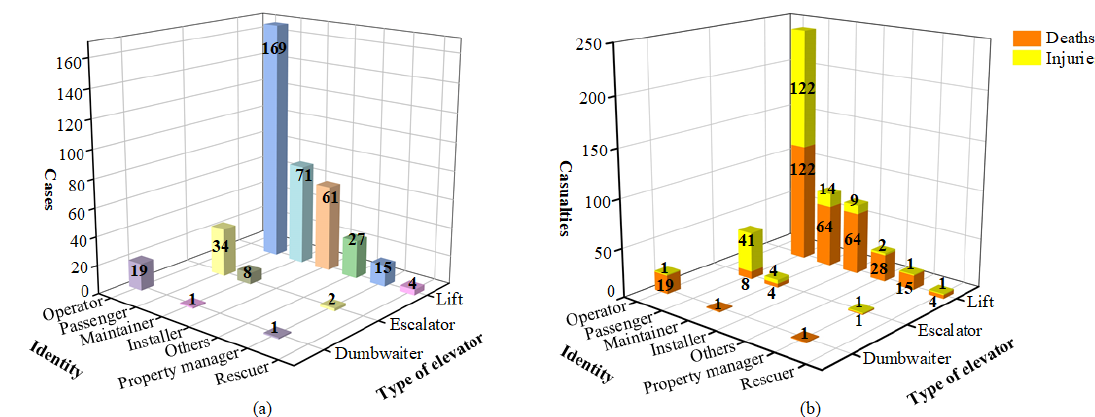
Fig. 5 Identity distribution of casualties. (a) The number of accidents according to the identity of the casualty and elevator type. (b) The number of casualties according to the identity of the casualty and elevator